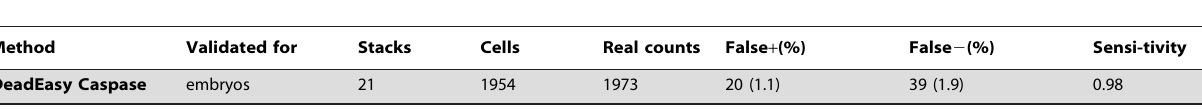
Table 2. Validation of DeadEasy Caspase